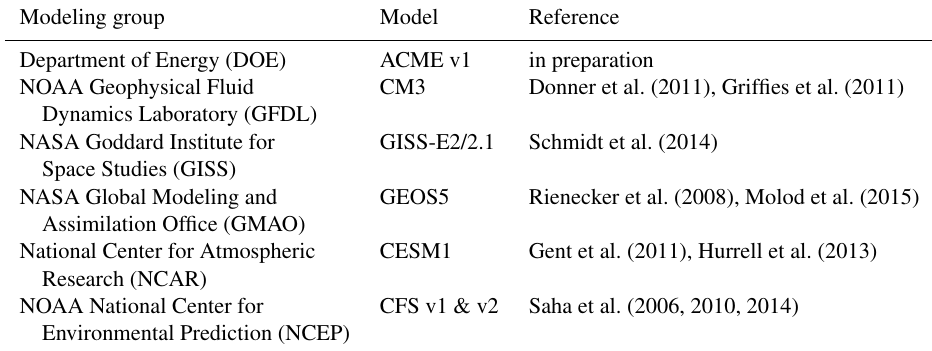
Table 1. Climate models discussed in the